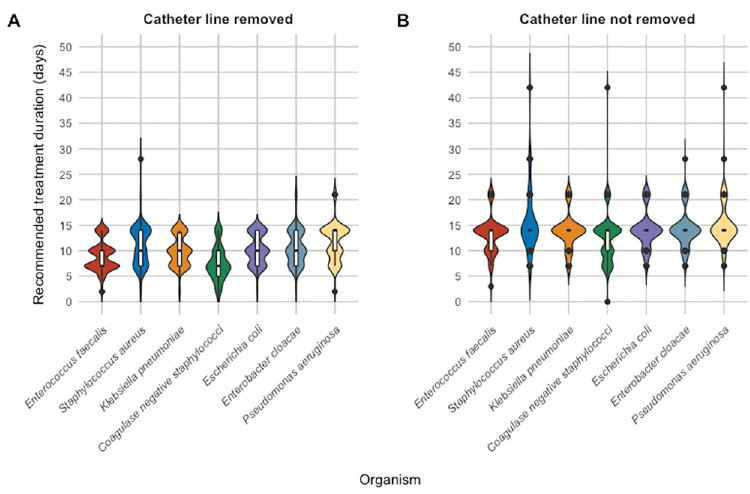
Fig 2. Violin plot distribution of recommended treatment durations for central vascular catheter-related bacteremia caused by different pathogens.